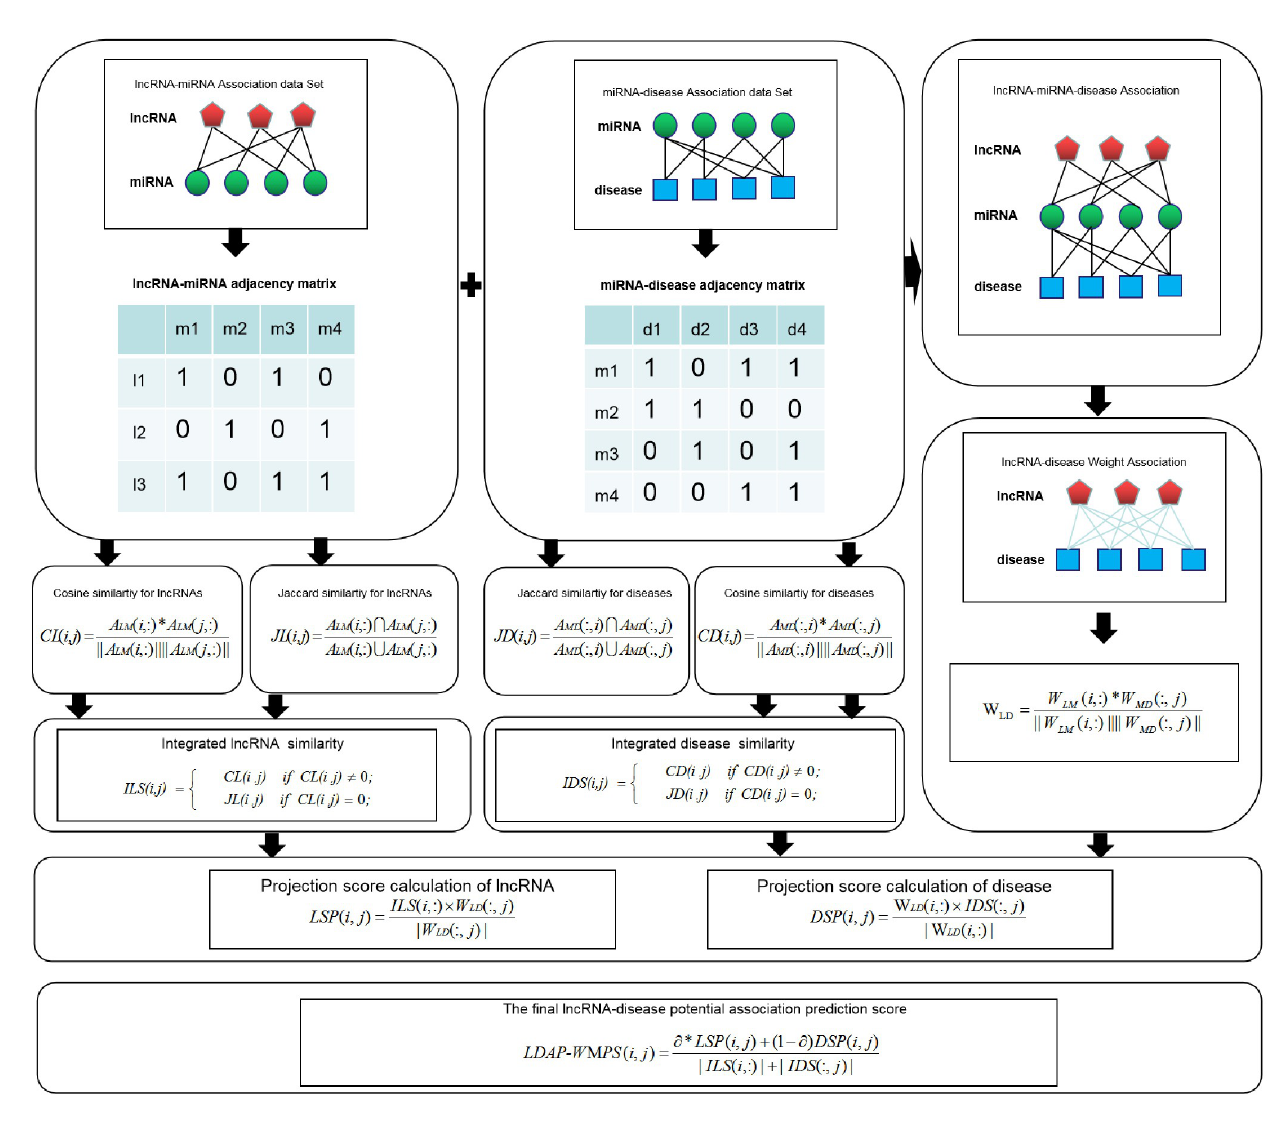
Fig 2. Flow chart of LDAP-WMPS applied to lncRNA-disease association